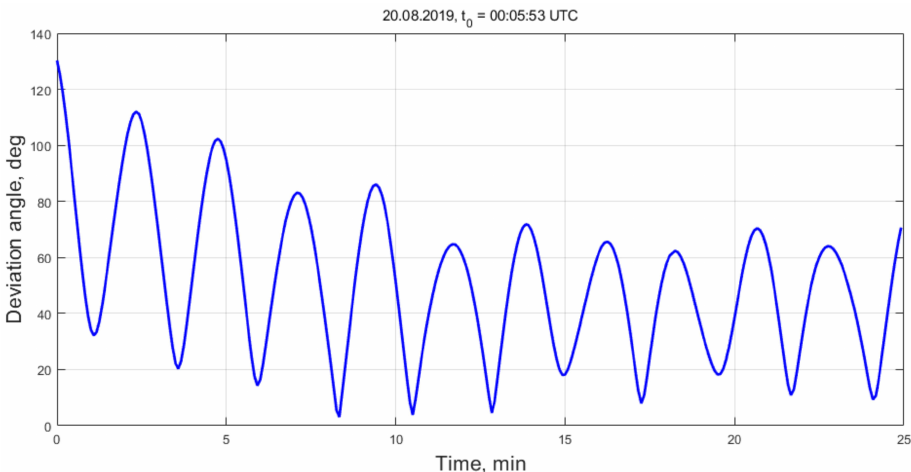
Figure 14. Deviation of OZ axis of the satellite from the flow